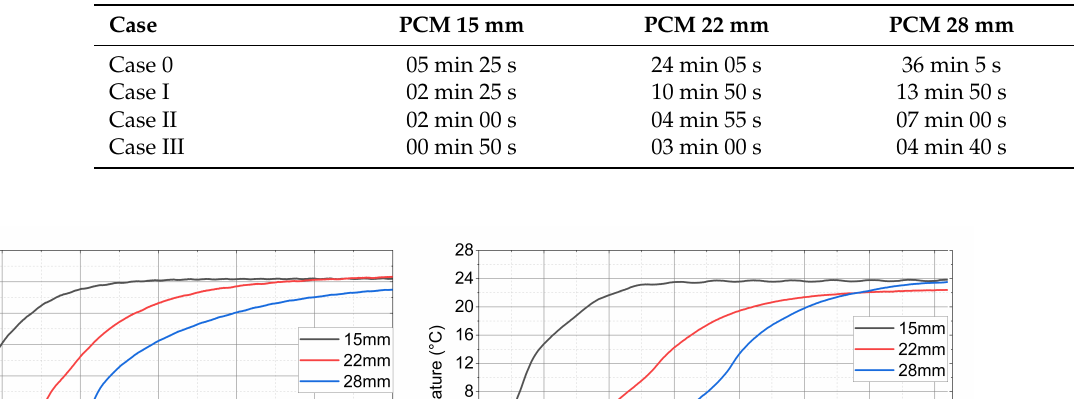
Table 7. Paraffin melting time.